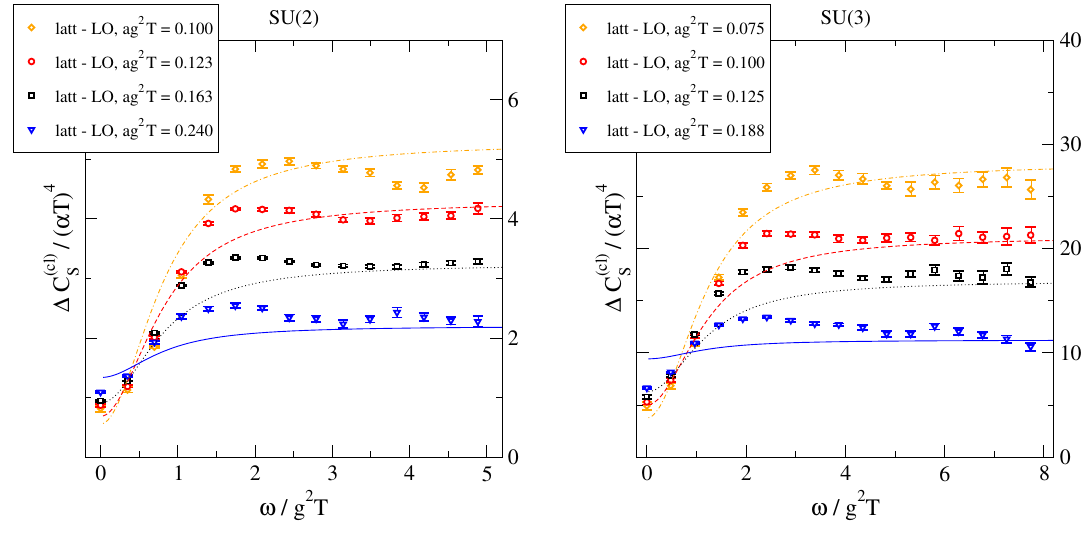
Figure 5 . Lattice data for ∆ C (cl) ( ω ) / ( αT ) 4 as a function of ω/ ( g 2 T ) , after the subtraction of the S perturbative contribution from appendix A, computed up to leading order (“LO”). The lines indicate a qualitative representation of the subtracted data, according to eqs. (6.13) and (6.14).